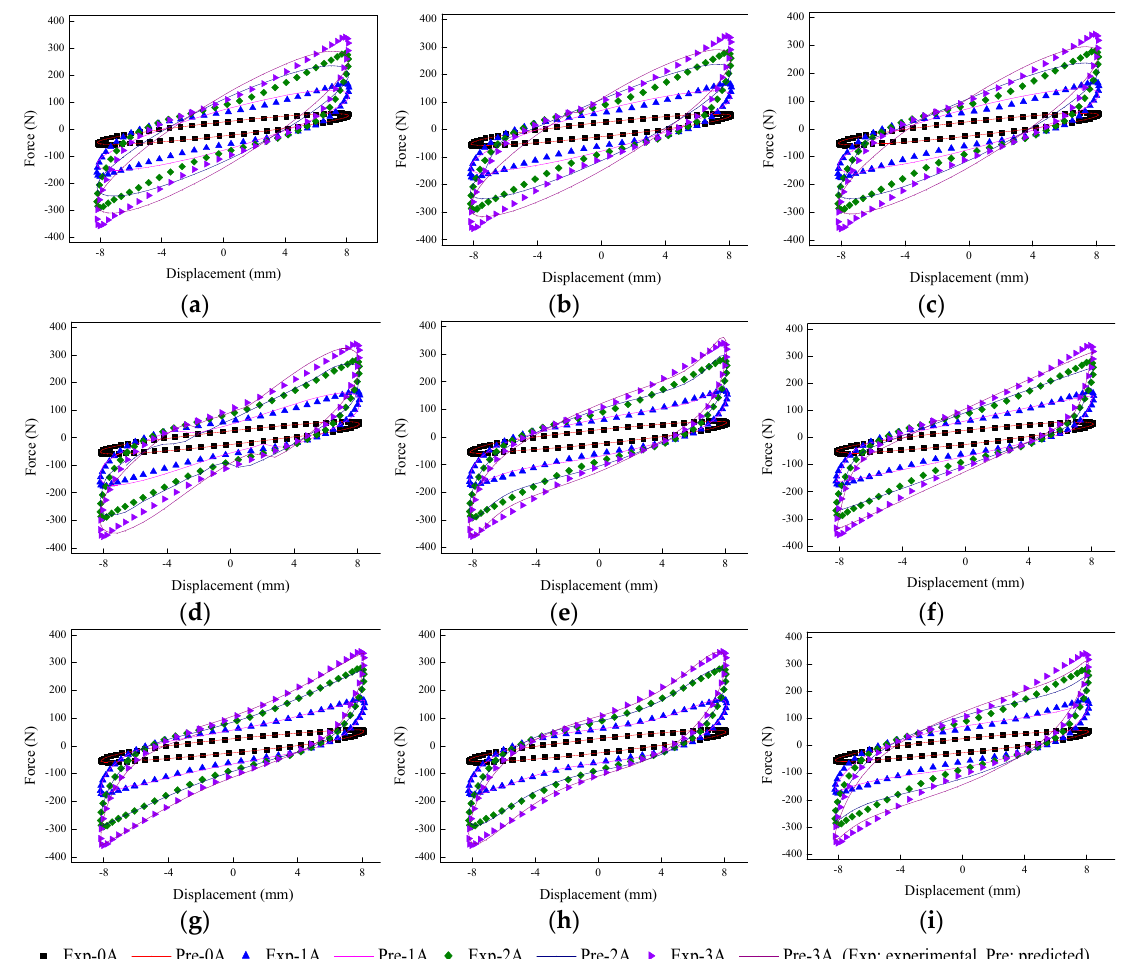
Figure 23. Comparisons of force–displacement responses between experimental results and model predictions when the loading amplitude is 8 mm. ( a ) Kelvin–Voigt model, ( b ) four-parameter viscoelastic model, ( c ) rheological model, ( d ) BW model, ( e ) improved BW model, ( f ) Dahl model, ( g ) improved LuGre friction model, ( h ) strain stiffening model, and ( i ) hyperbolic hysteresis model.